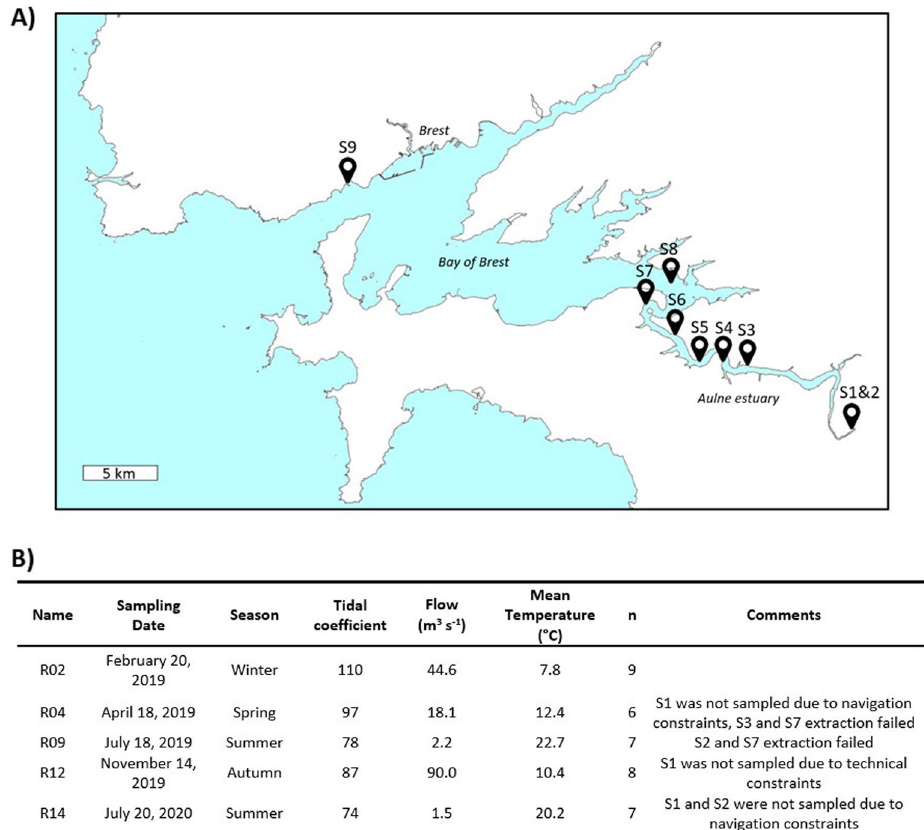
Figure 1. (A) Map of the Bay of Brest and the Aulne estuary; sampling dates and their associated tidal coefficient, river flow and mean water temperature. Freshwater (S1, S2) and marine water (S9) stations were collected at fixed locations, while the other stations were variable depending on the salinity. The locations of the April sampling (R04) stations are indicated as an example. Modified from data.shom.fr. ( B ) Sampling dates and their associated tidal coefficient, river flow and mean water temperature. n: number of sampled stations. Flow data were retrieved from http:// www. hydro. eaufr ance. fr/ at the Châteaulin station